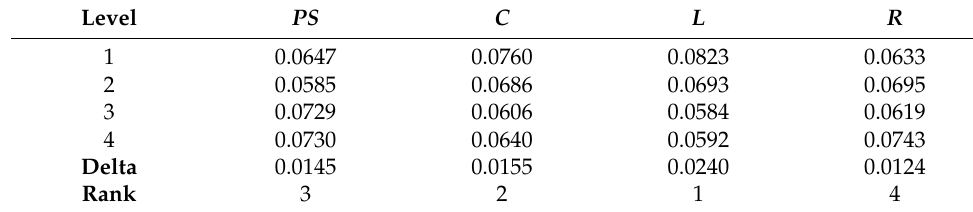
Figure 7. The trend of the parameter level. Table 4. The average RPI response values.